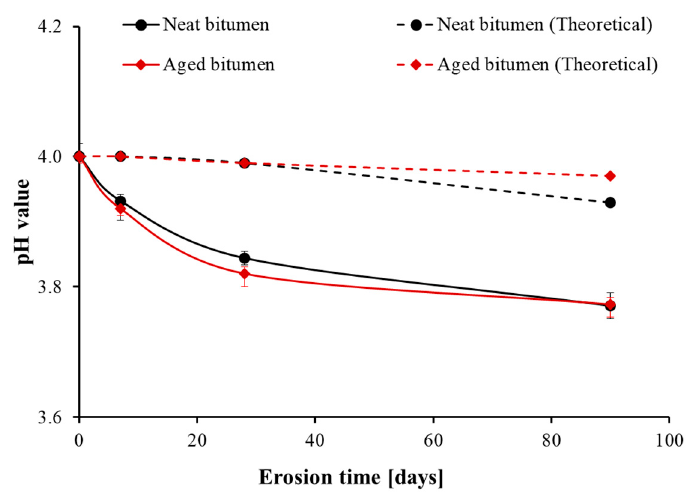
Figure 1. The pH value of simulated acid rain after eroding neat bitumen and aged bitumen.